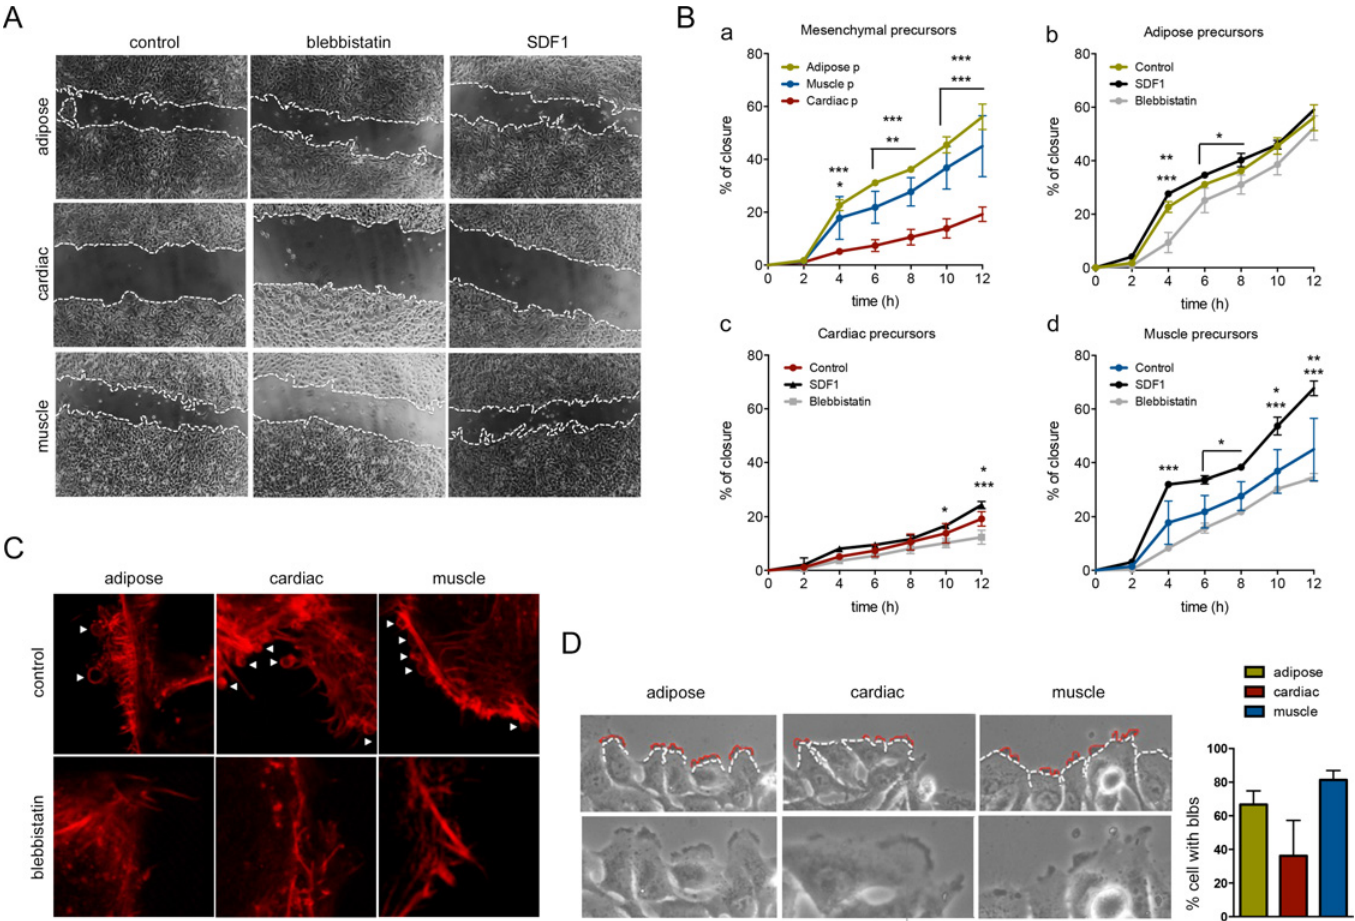
Fig 5. MP wound-healing (migration) assay. (A) Representative 10x images of wounding at 12h are shown. (B) Graphs of wound closure percentage from triplicate samples at each 2 hours over 12h; Statistical analysis were performed using 2 Way-ANOVA and Turkey´s multiple comparisons test to evaluated each condition each hour; * P < 0.05; ** P < 0.01; *** P < 0.001. (a) Comparison of mesenchymal precursors in control conditions (Asterisks above correspond to adipose precursors-cardiac precursors, and asterisk below correspond to muscle precursors-cardiac precursors). (b) Comparison between adipose precursors in control conditions and the same cells with blebbistatin and SDF1 (One row of asterisks refers to SDF1-blebbistatin and in two row of asterisks the above ones are related to control-blebbistatin and the below ones to SDF1-blebbisttatin). (c) Comparison of cardiac precursors in control blebbistatin and SDF1 conditions. (One row of asterisks refers to SDF1-blebbistatin and in two row of asterisks the above ones are related to control- blebbistatin and the below ones to SDF1-blebbisttatin). (d) Comparison of muscle precursors in control blebbistatin and SDF1 conditions. (One row of asterisks refers to SDF1-blebbistatin and in two row of asterisks the above ones are related to control-blebbistatin and the below ones to SDF1-blebbisttatin). (C) Higher magnification of F-actin staining of precursors (63x) in control and blebbistatin conditions. Blebs (marked with white arrows) can be visualized in the membrane of control cells at the leading edge of the cells localized at the front of the wound. (D) Representative phase contrast 20x images of the leading edge of cells that were migrating through the wound are shown. White discontinued lines defined lamellipodia and red lines delimited blebs in the cells. Higher magnification of these images is also shown at the below panel where blebs can be distinguished in black. Quantification of the percentage of cells with blebs at the front of the wound; non statistical differences were found using Mann-Whitney